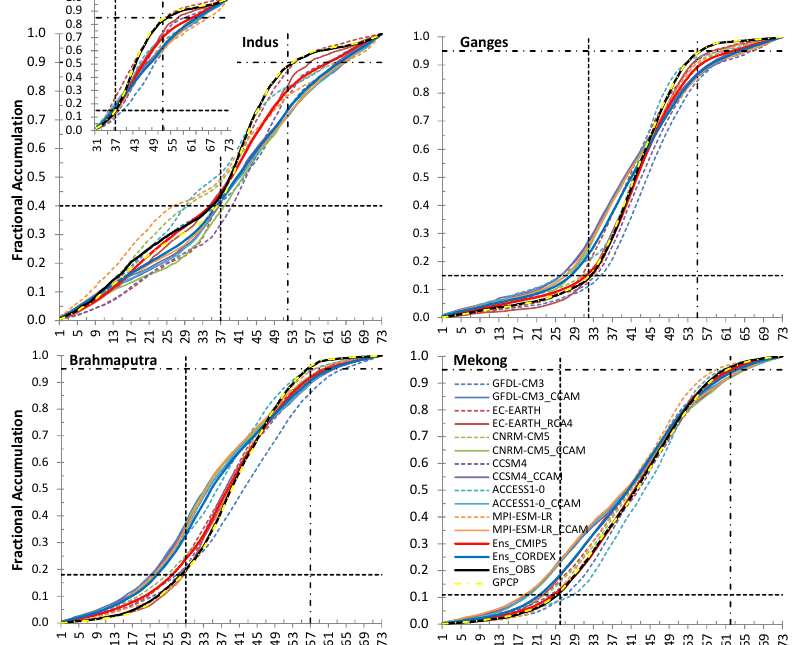
Figure 4. Fractional accumulation of precipitation; comparison of five CMIP5 experiments that are downscaled with a single RCM of CCAM as well as the EC-EARTH CMIP5 experiment downscaled with RCA4 RCM. The GPCP and the ensemble means of OBS, CX-SA and CMIP5 are also shown. For Indus, the inset shows the fractional accumulation excluding January to May period of